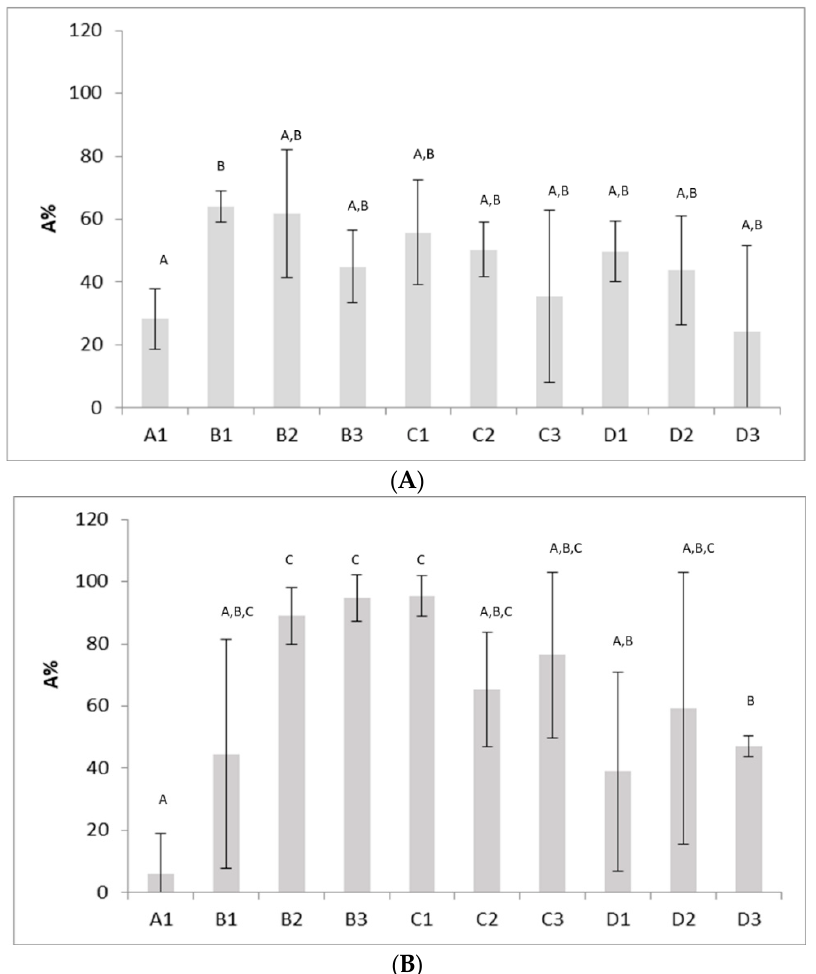
Figure 2. Autoaggregation percentage (A%) of S. cerevisiae 2 ( A ) and S. cerevisiae 17 ( B ), 2 h after the US treatment. Mean values ± standard deviation. A1, untreated yeast. The letters indicate significant di ff erences (one-way ANOVA and Tukey’s test, p < 0.05).